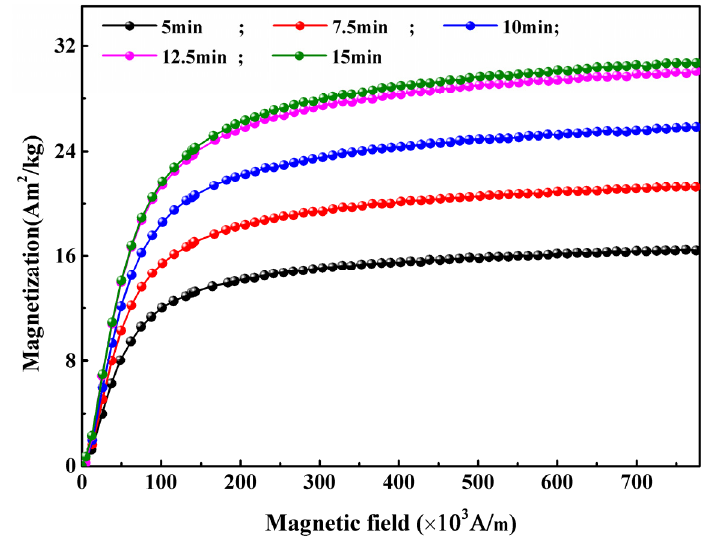
Figure 7. Magnetization curves of roasted products.